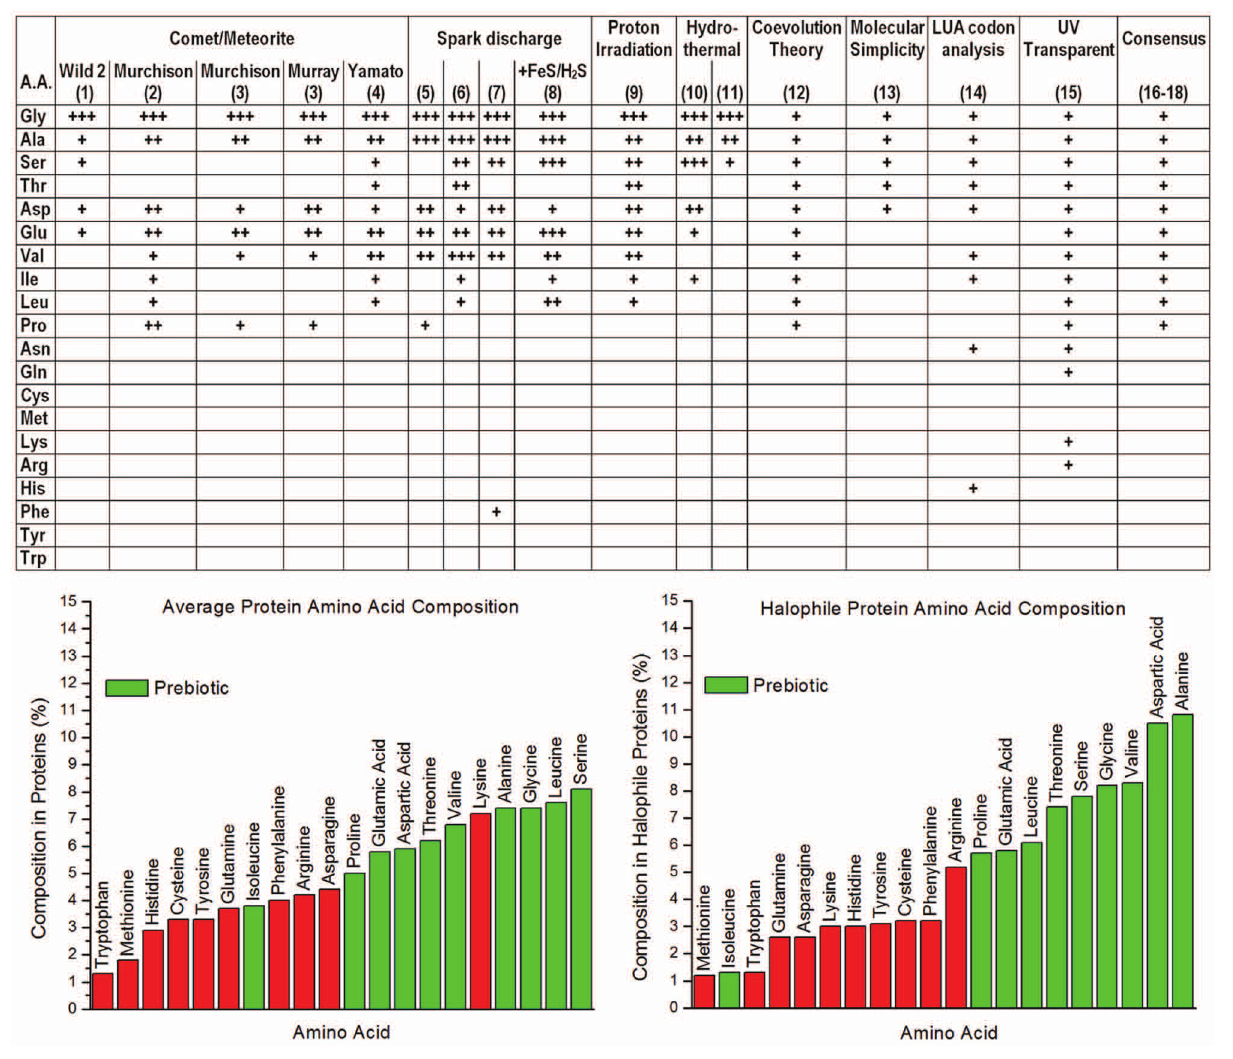
(2005); (13) Cleaves (2010); (14) Brooks et al. (2002); (15) Cockell and Airo (2002)]. Lowerpanel: (left)theaverage α -aminoacidcompositioninallproteins, with green indicating the prebiotic amino acids, Red bars indicate biotic amino acids (King and Jukes, 1969; Dyer, 1971); (right) the average α -amino acid composition in halophile proteins, with green indicating the prebiotic amino acids, Red bars indicate biotic amino acids (Fukuchi et al.,